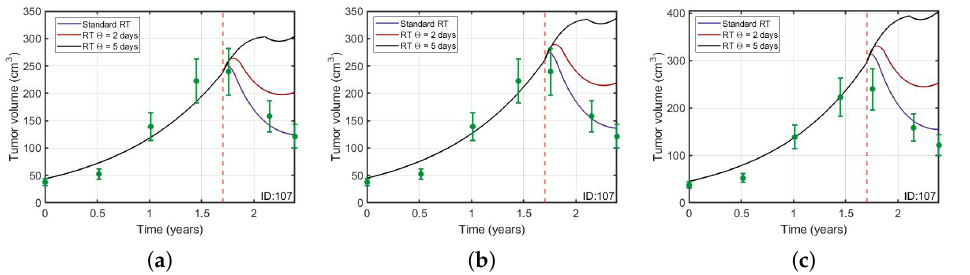
Figure 6. Same simulations as in Figure 5 for three different sets of parameters taking into account the 18% error in the real tumor volumes.